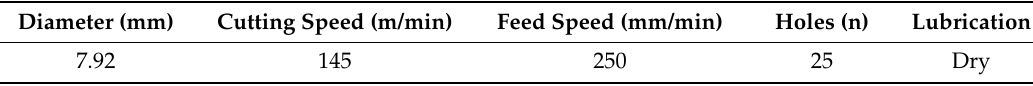
Table 1. Tested cutting conditions.